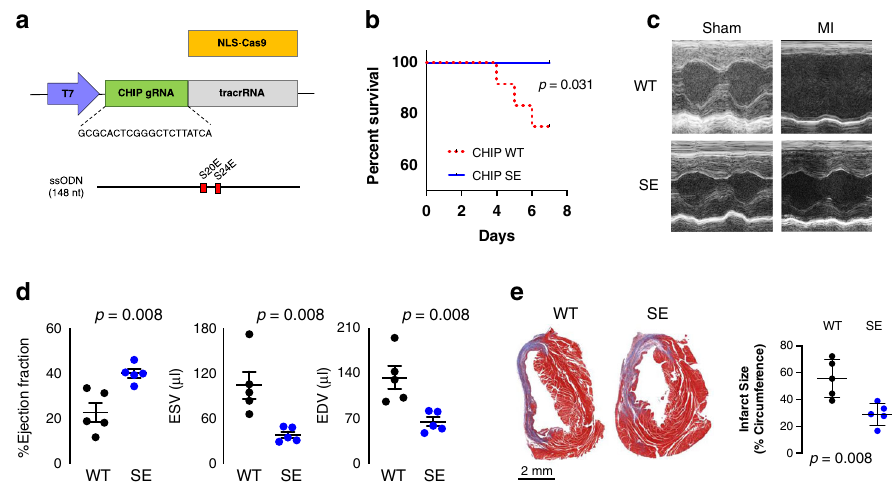
Fig. 8 Mice with global S20E KI are protected against myocardial infarction. a Guide RNA to target CHIP S20/S24 region, and the replacement RNA that includes a silent mutation of the PAM sequence to further enhance homology directed repair . b CHIP S20E ( n = 10 heterozygous; n = 7 homozygous) mice have reduced mortality following myocardial infarction due to total coronary occlusion. c Example M-mode echocardiograms show improved wall motion and less heart dilation in CHIP S20E (SE) KI mice versus littermate (WT) controls. d Summary data for LV function and volumes from same experiment. N = 5 mice for each group, mean ± SEM, p -value shown for Mann – Whitney test unpaired test. e Whole heart cross-section histology shows larger infarct territory in WT versus CHIP S20E hearts. Summary quantitation (right). N = 5 biological replicates, mean ± SD, p value for Mann – Whitney unpaired test. Source data are provided as a Source Data fi le.